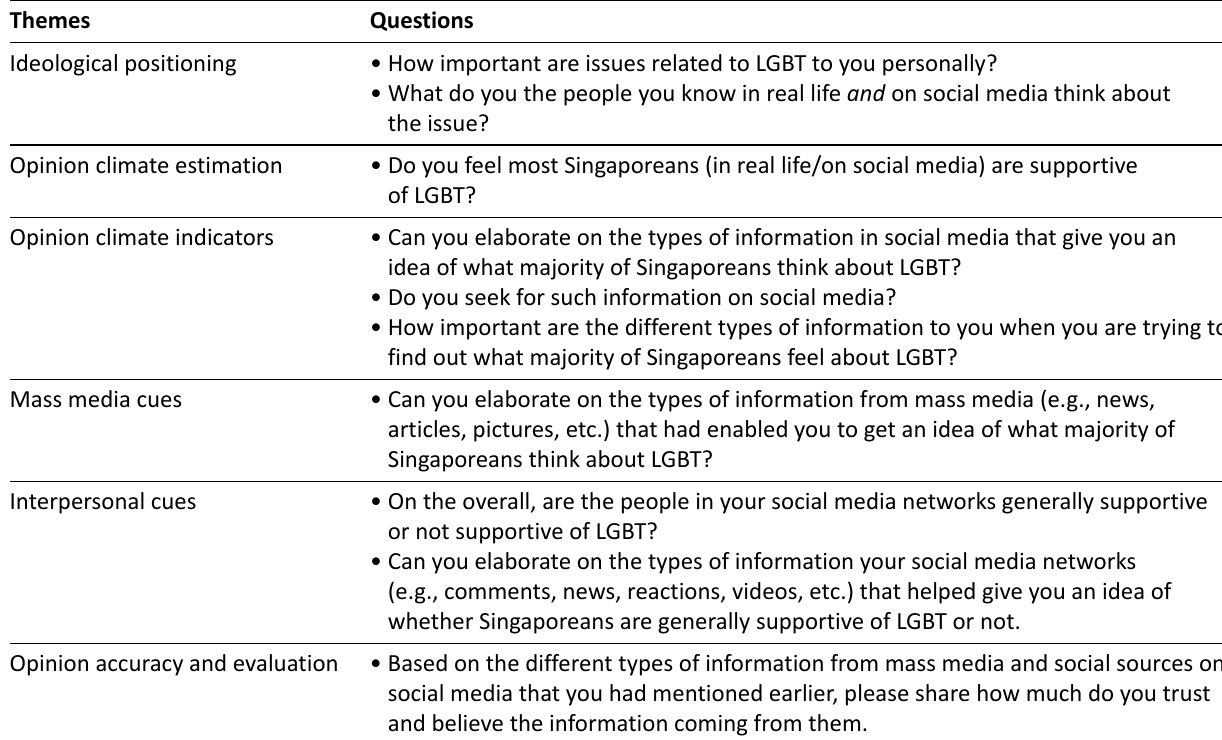
Table 1. Themes and questions in focus group and data